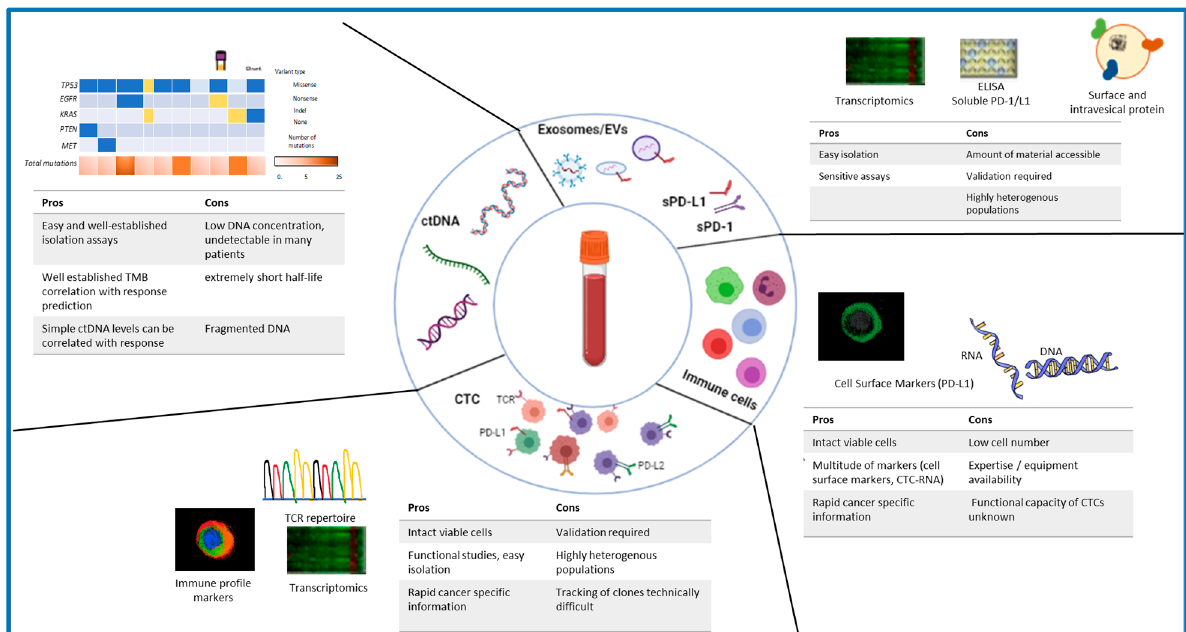
Figure 2. Liquid biopsy analysis in the immunotherapy context. Major sources for immunotherapy biomarkers derived from blood. Sources of liquid biopsy biomarkers are enlisted with major advantages (pros) and disadvantages (cons) associated with their application in clinical settings. Here, we review the current knowledge of these liquid biopsy biomarkers as predic- tors of response to IO and their potential to guide clinical decisions for IO. We will focus on circulating tumor DNA, circulating tumor cells (CTCs), and the types of markers ex- pressed on peripheral blood mononuclear cells (PBMCs). Other biomarker such as sPD-1, sPD-L1, EVs, and exosomes are also briefly discussed. Table 1 lists the example studies on the prognostic value of ctDNA, CTCs, and immune cells in immunotherapies. Table 1. Representative studies on the prognostic value of ctDNA, CTCs, and immune cells in var- ious immune checkpoint inhibitor therapies.